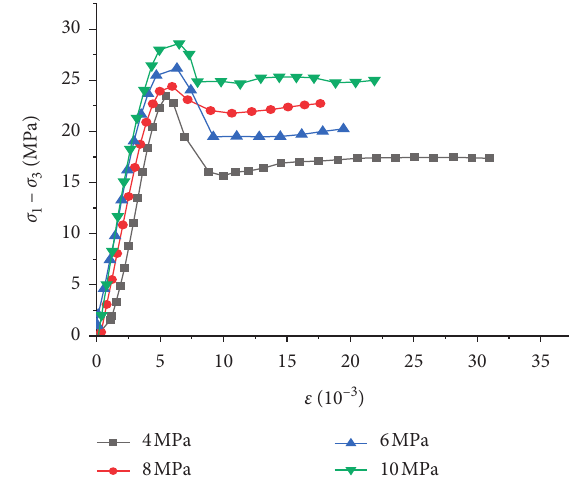
Figure 3: Stress-strain curves of sandstone samples under different confining